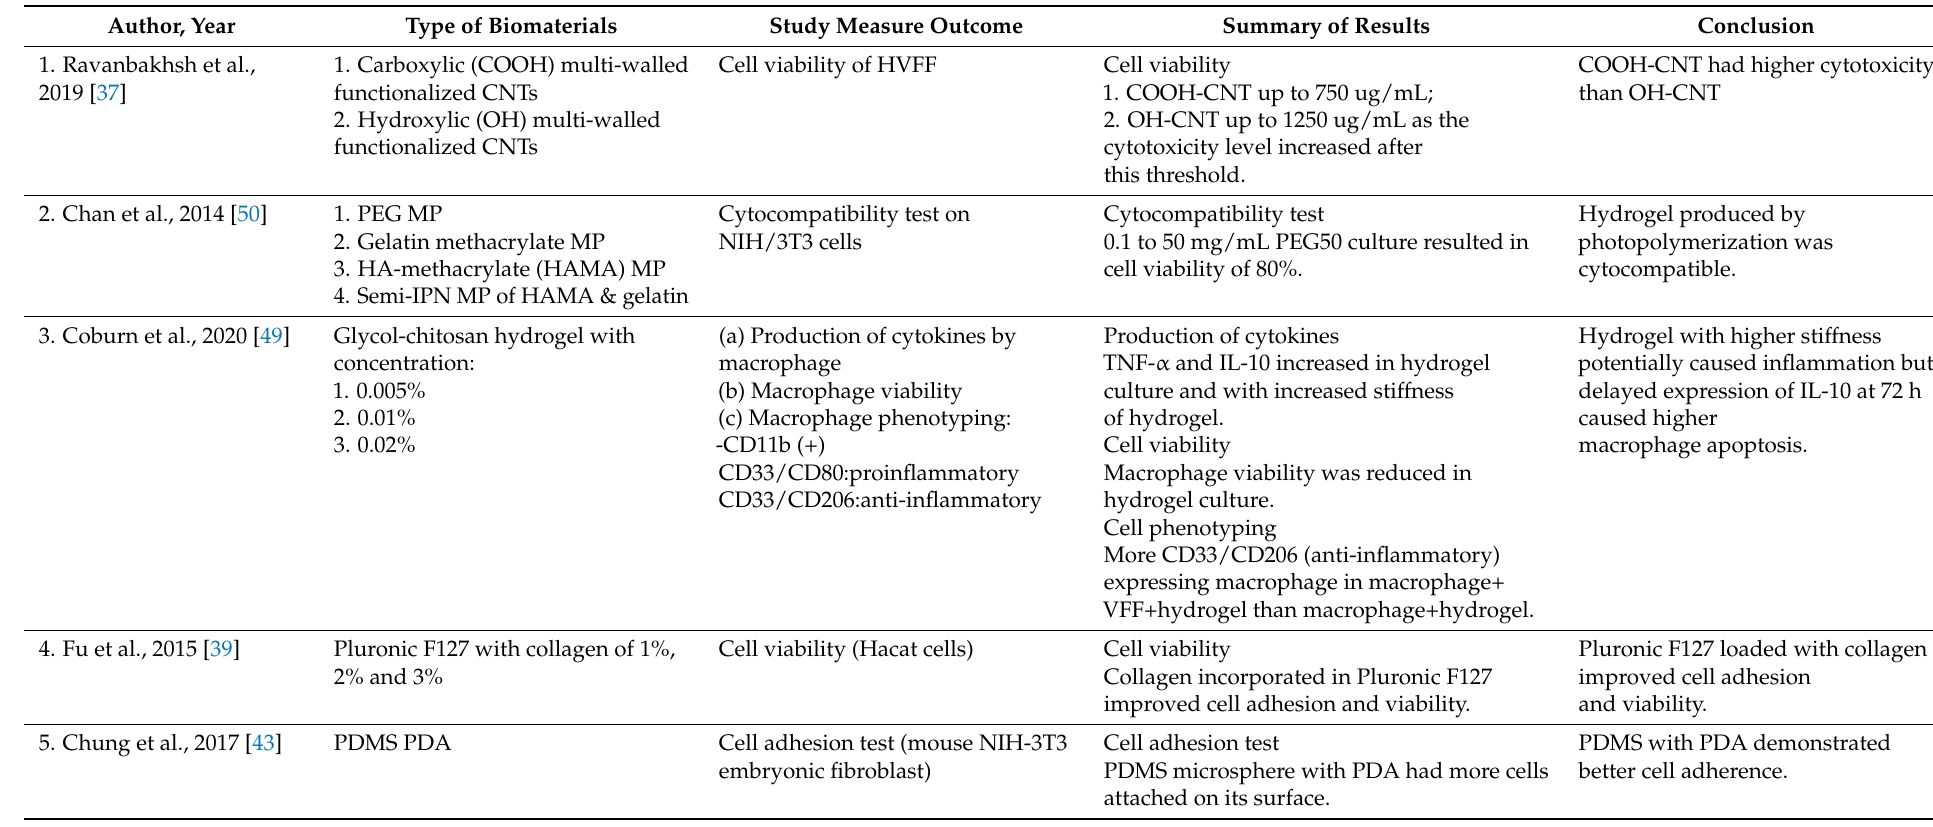
Table 4. In vitro